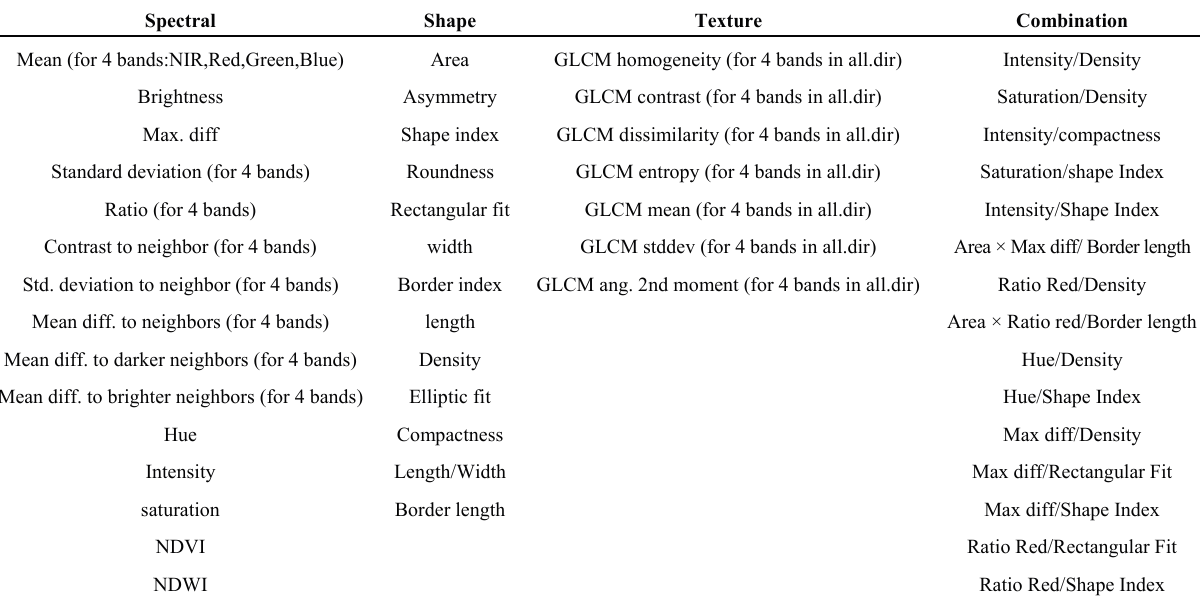
Table 1. All of the features that should be generated for each